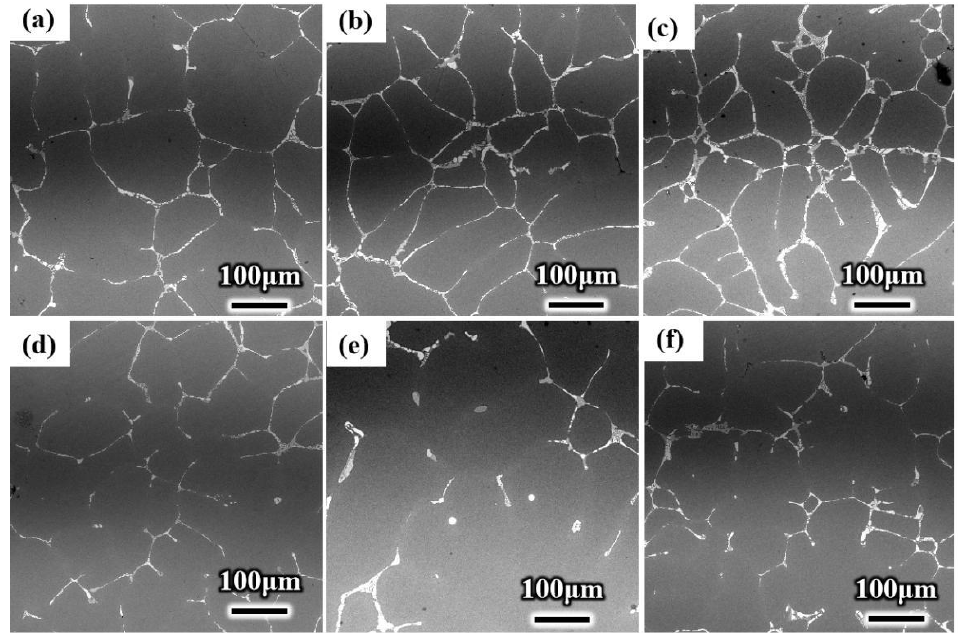
Figure 5. The eutectic phase distribution of the ultrasonic ingot and conventional ingot. ( a ) Edge of conventional ingot; ( b ) 1/2 radius of conventional ingot; ( c ) center of conventional ingot; ( d ) edge of ultrasonic ingot; ( e ) 1/2 radius of ultrasonic ingot; ( f ) center of ultrasonic ingot.